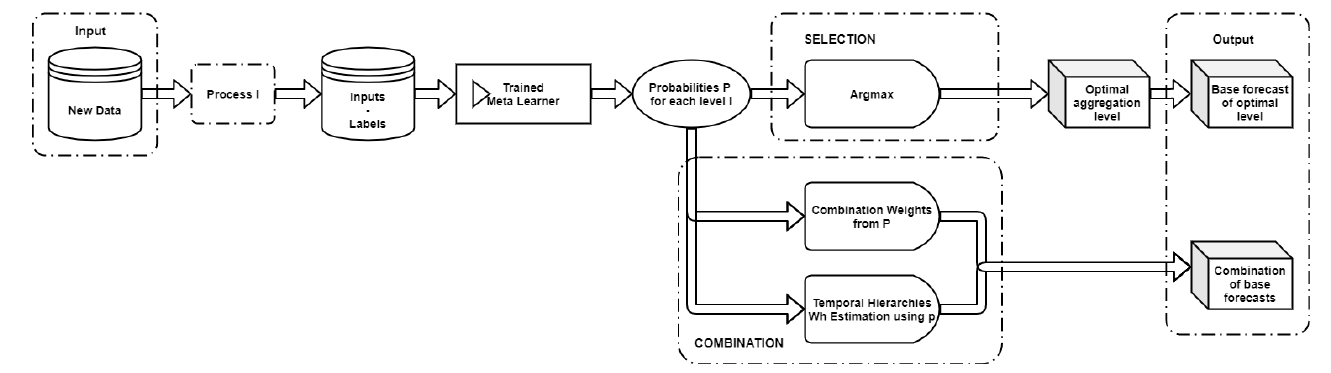
Figure A2. The online phase of the proposed